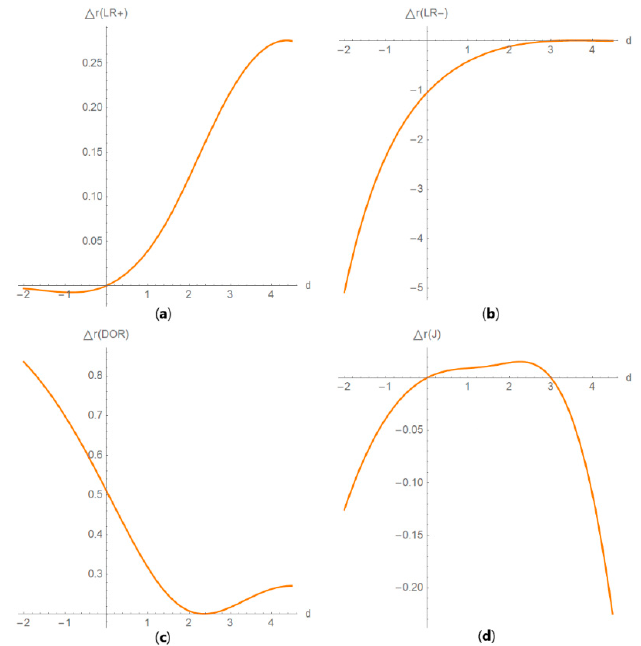
Figure 14. DAM relative differences against prevalence plots. Plots of the relative difference of the ( a ) positive predictive value ( PPV ), ( b ) negative predictive value ( NPV ), ( c ) overall diagnostic accuracy ( ODA ) and ( d ) risk ( R ) of two diagnostic or screening tests measuring the same measurand with different uncertainties, against prevalence ( v ) curves, with the respective parameters in Table 4.